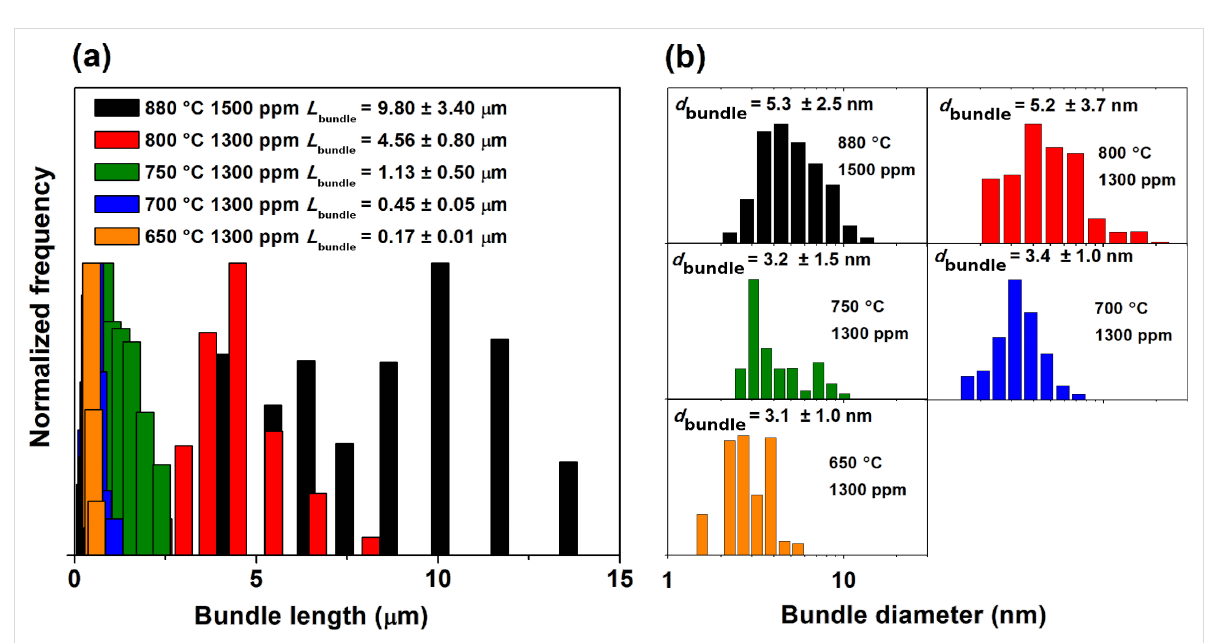
Figure 3: (a) Bundle length statistics measured from SEM images, and (b) bundle diameter statistics from TEM